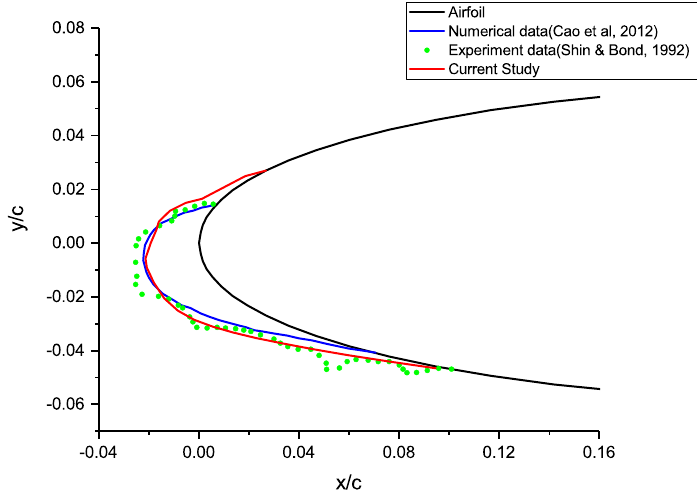
Figure 1. Visualization of the ice shape comparison on the NACA0012 airfoil